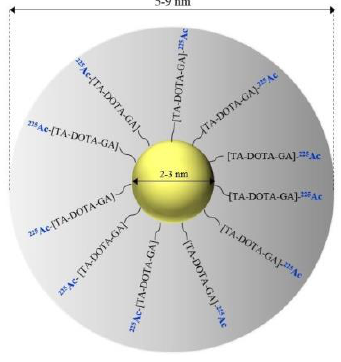
225 Ac-Au@TADOTAGA Figure 5. Schematic of an 225 Ac-Au@TADOTAGA radiobioconjugate. Figure 5. Schematic of an